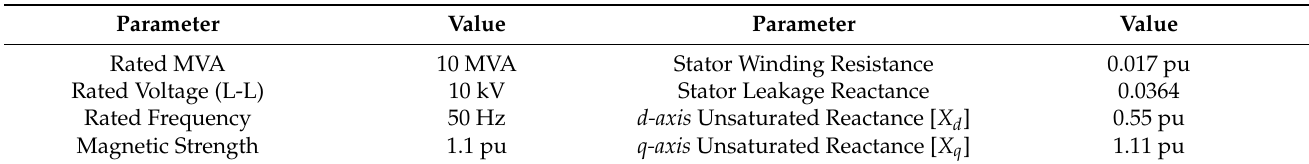
Table 2. Parameters of PMSG.